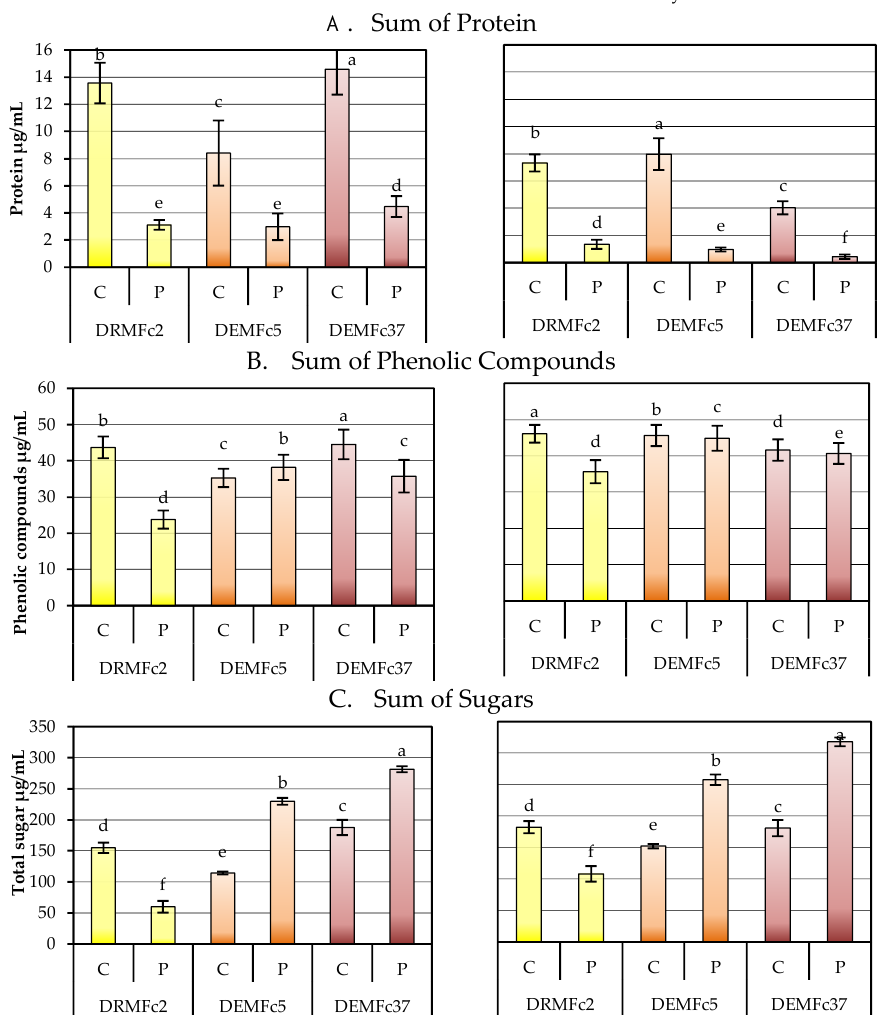
Figure 11. Sum of protein ( A ), phenolic compounds ( B ) and total sugar ( C ) in three I. Solutions (water, sodium hydroxide, hydrochloride) obtained by dissolving EPS directly in each of the three solvents and three II. fractions (aqueous-water, alkalic-sodium hydroxide, acidic-hydrochloride) obtained in step fractionation of crude (C) and proteolysed (P) EPS from cultures of three F. culmorum strains: DEMFc2, DEMFc5, and DEMFc37. ANOVA with post hoc Tukey’s HSD test, p < 0.05. Mean values labeled with the same letter within the same series are not significantly different ( p > 0.05). Standard deviations are shown as deviation bars ( n = 9).